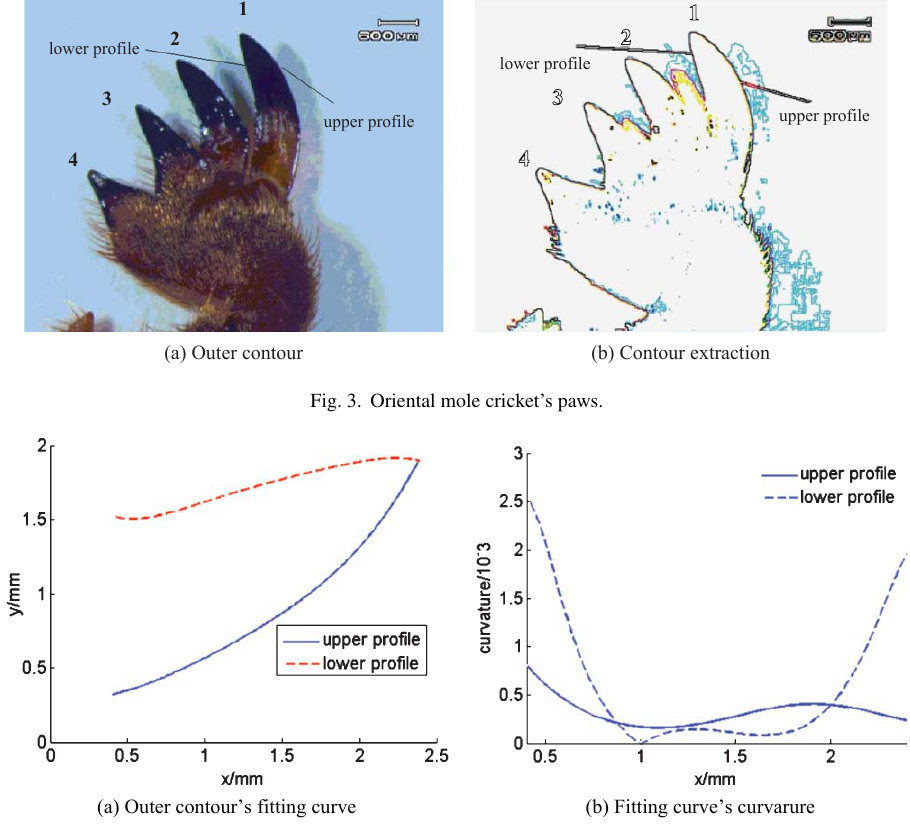
Fig. 3. Oriental mole cricket’s paws.